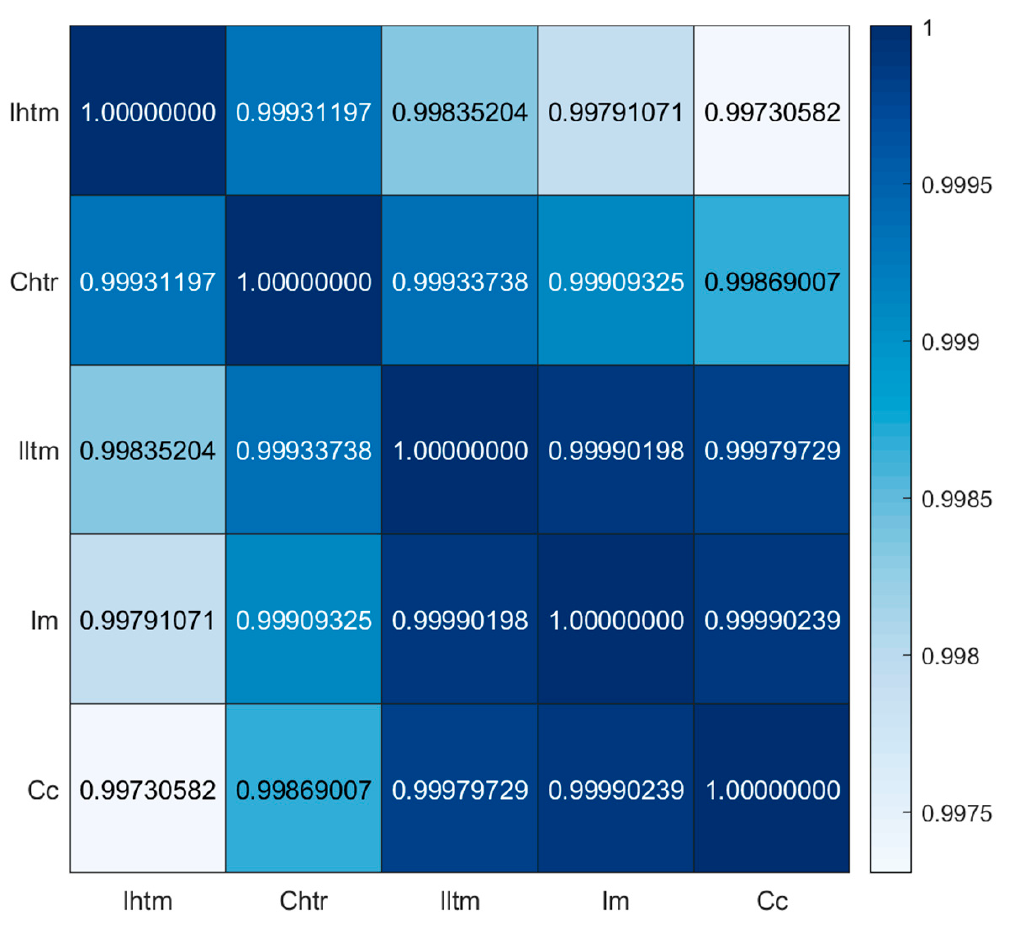
Table 1. Normalized distance between mare basalt units. Ihtm-Chtr Ihtm-Iltm Ihtm-Cc Ihtm-Im Chtr-Cc T Bnoon 3.0 GHz T Bmidnight 3.0 GHz